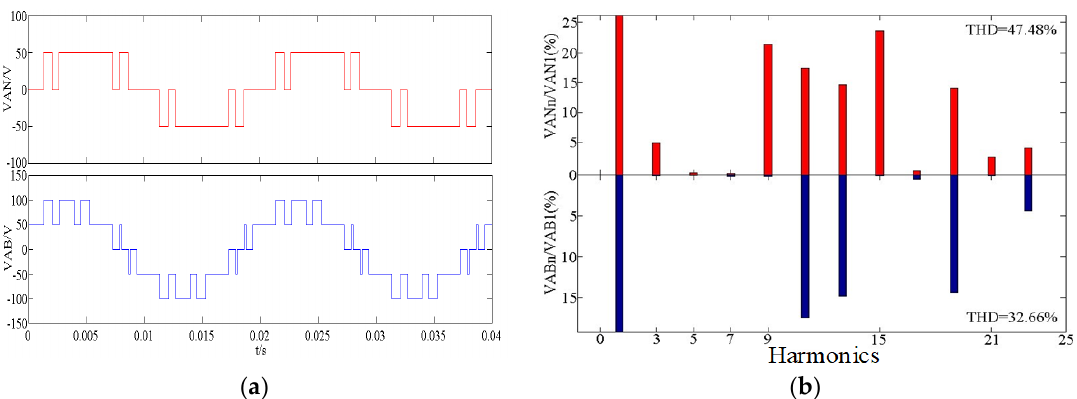
Figure 7. Simulation waveform based on the C waveband when U1 = 1.0. ( a ) Simulation waveforms of phase and line voltages. ( b ) Spectrum distribution of phase and line voltages.